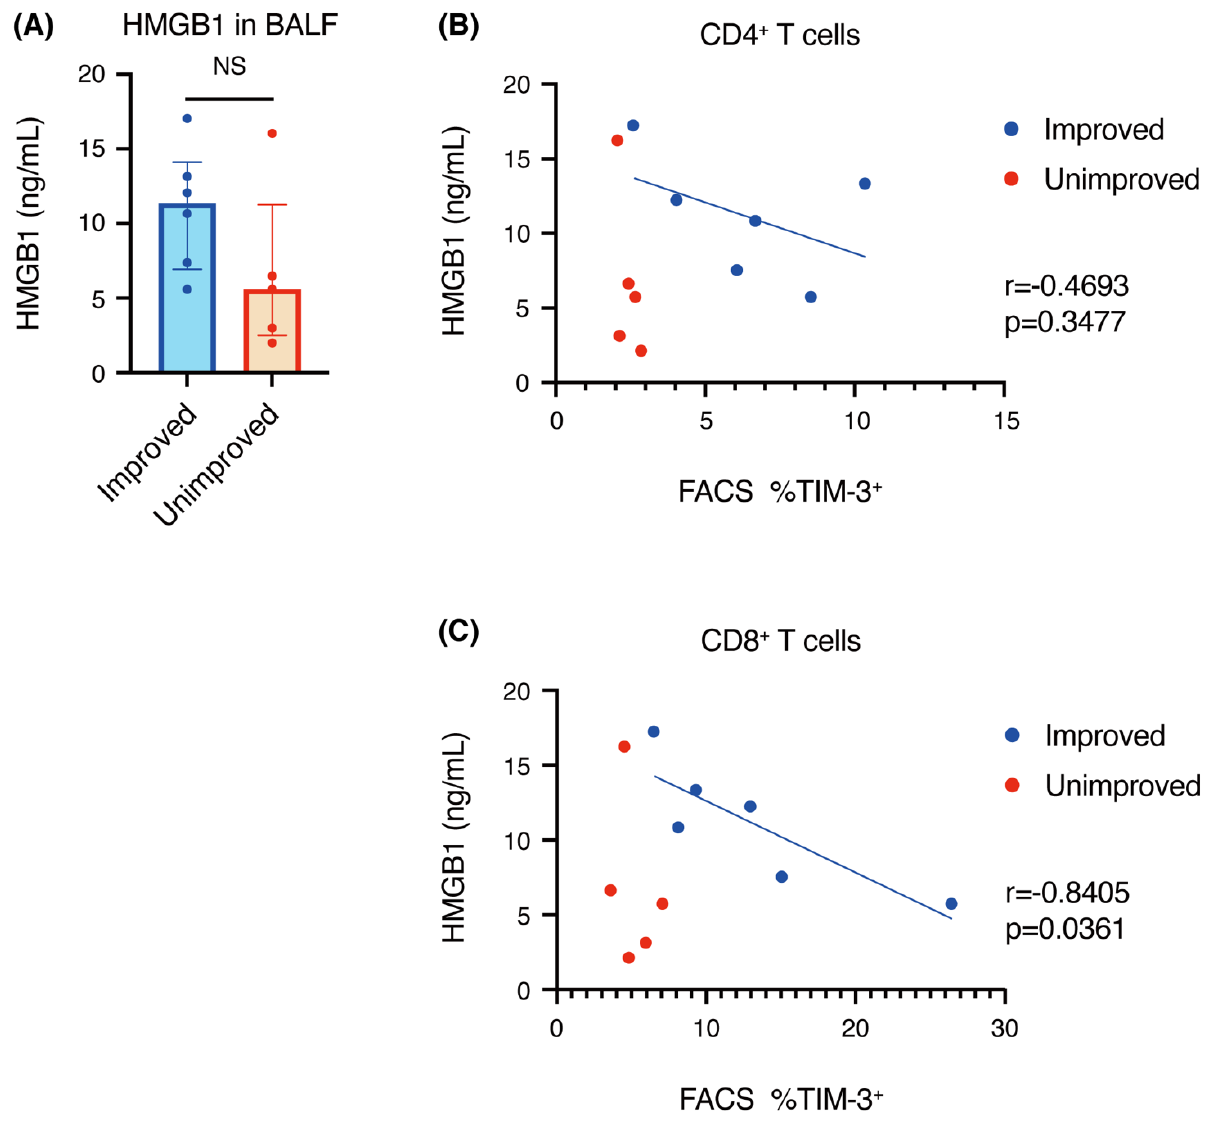
Figure 5. Correlation of the concentration of high mobility group box 1 (HMGB1) with the proportion of T-cell immunoglobulin- and mucin-domain-containing molecule-3 (TIM-3) positive T cells among CD4 + or CD8 + T cells in bronchoalveolar lavage fluid (BALF). ( A ) The concentration of HMGB1 in BALF was measured by ELISA. Individual patient data as well as medians and interquartile ranges are shown. ( B , C ) Correlation of the HMGB1 concentration with the proportion of TIM3 + cells among CD4 + T cells ( B ) or CD8 + T cells ( C ). Statistical analysis for Pearson’s correlation was performed using Student’s t -distribution. NS: not significant.